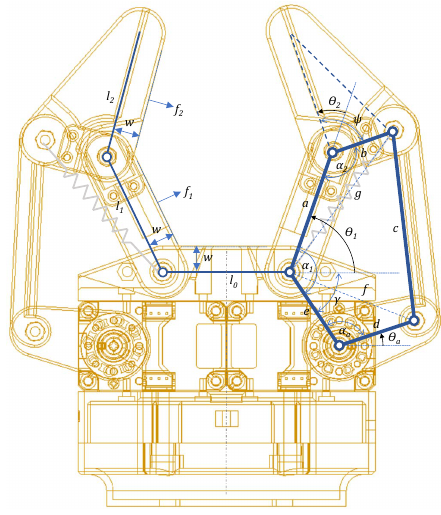
Figure 2. Kinematic design of the gripper for pHRI showing the parameters and joint angles. For clarity, every finger has been partially